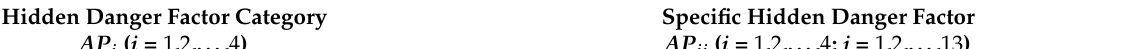
Table 2. Preliminary Identification Results of Hidden Danger Factors of Electric Power Personal Casualty Accidents. Hidden Danger Factor Category AP i ( i = 1 , 2 ,..., 4